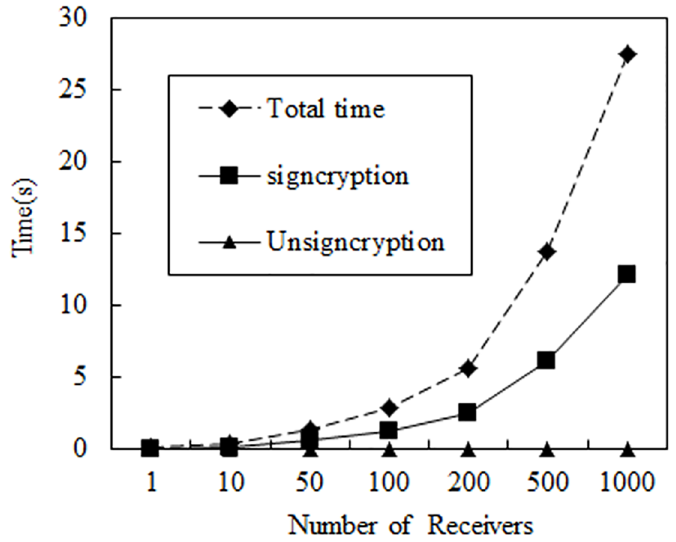
Fig 1. Operation time(s). (Unsigncryption time near the bottom of the coordinateaxis).